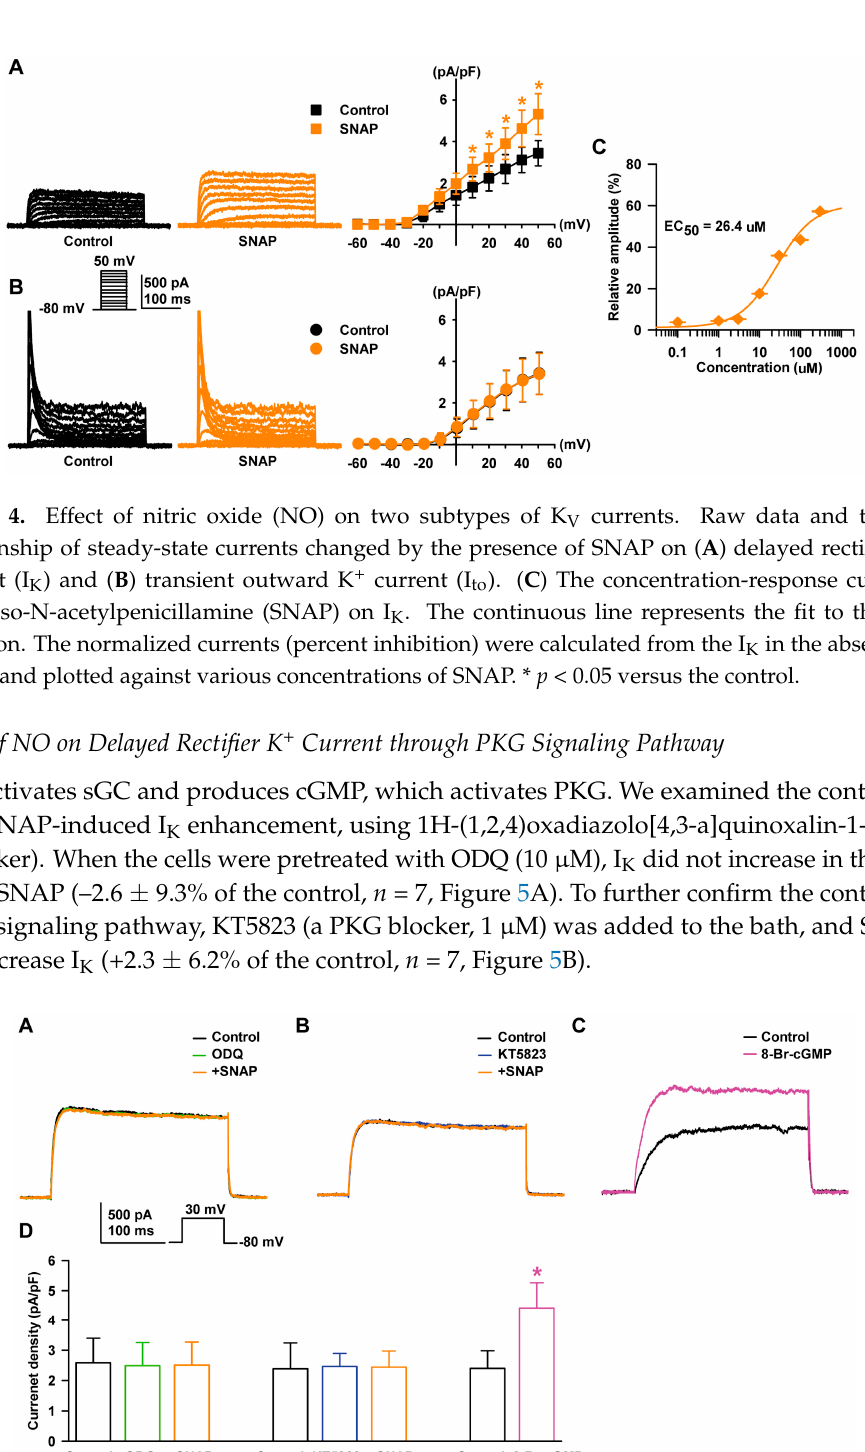
Figure 5. Effects of the PKG pathway on the stimulating effect of NO on I K . Representative currents showing the effect of SNAP on I K after pretreatment with ( A ) 1H-(1,2,4)oxadiazolo[4,3-a]quinoxalin- 1-one (ODQ) or ( B ) KT5823. ( C ) Effect of 8-Br-cyclic GMP on I K . ( D ) Bar graph summarizing current density changes for the effects of SNAP on I K after pre-incubation with ODQ or KT5823, and the effect of 8-Br-cyclic GMP on I K current. * p < 0.05 versus the control. We also assessed the effect of cGMP, which is generated from NO binding to sGC. 8-Bromo-cyclic GMP (8-Br-cGMP, an activator of PKG, 300 µ M) increased I K to +84.0 ± 14.5% of the control ( n =